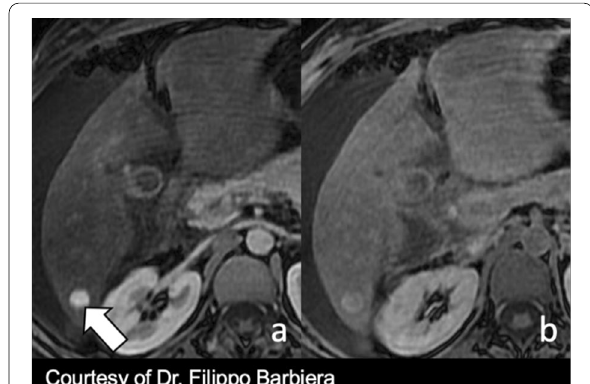
Fig. 6 A 38‑year old woman with Budd–Chiari syndrome and FNH‑like nodule. Gadobenate dimeglumine‑enhanced MRI demonstrates a FNH‑like nodule that shows ( a ) arterial phase hyperenhancement (arrow) and ( b ) hyperintensity in the hepatobiliary phase